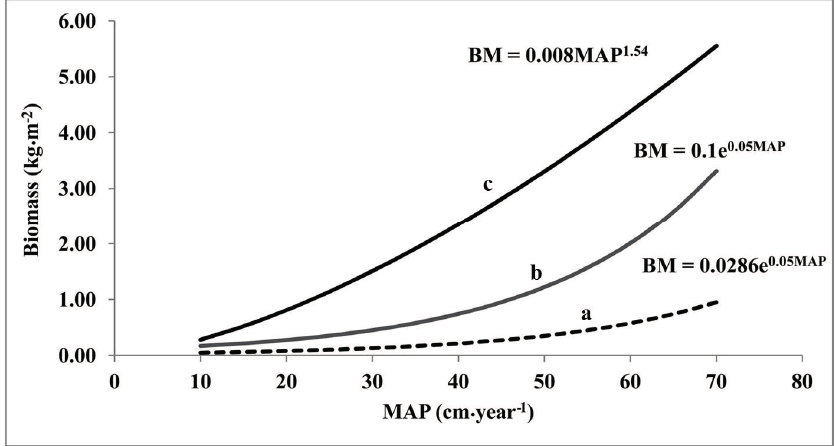
Figure 1. Generalized relationships between shrubland biomass and mean annual precipitation (MAP): ( a ) for desert fringe areas; ( b ) for sites representing different disturbance levels across the Mediterranean and semi-arid regions; and ( c ) for 100% shrub